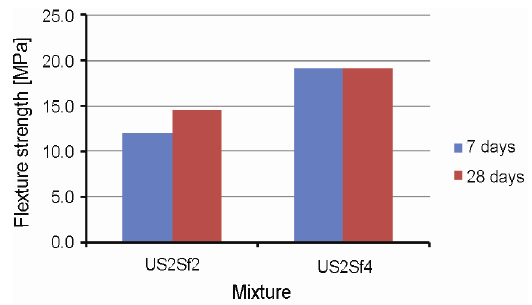
Fig. 6. Flexural strength test results on samples of 10×10×40